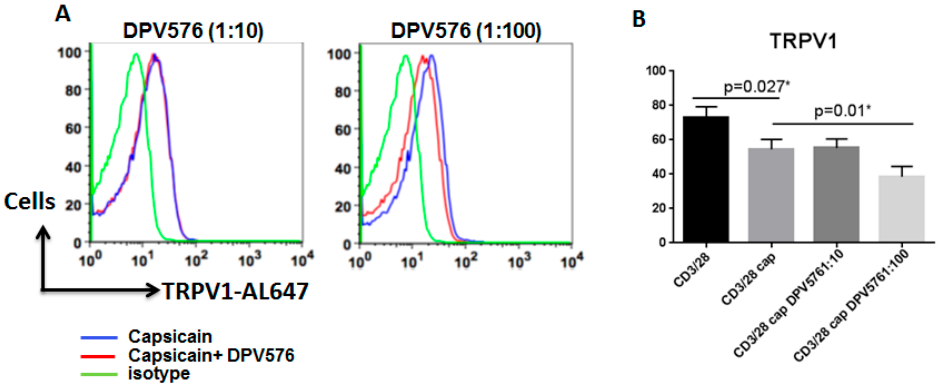
Figure 5. DPV576 downregulated the expression of TRPV1 in capsaicin activated in CD4 + T cells. Anti-CD3/CD28 + capsaicin activated CD4 + T lymphocytes in the presence of DPV576 for 24 h. The cells were stained for TRPV1. ( A ) Data is representative of three experiments. Blue: capsaicin; Red: capsaicin + DPV576 exposed lymphocytes; Green: anti-CD3/CD28. ( B ) Bar graph depicts the mean ± S.E. of the